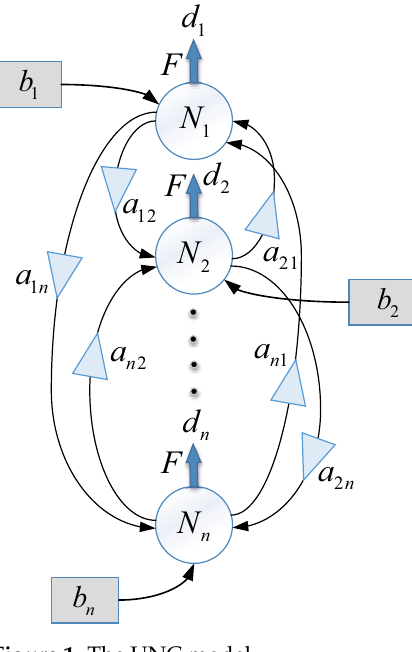
Figure 1. The UNC model. Table 1. The neuron interaction matrix of the